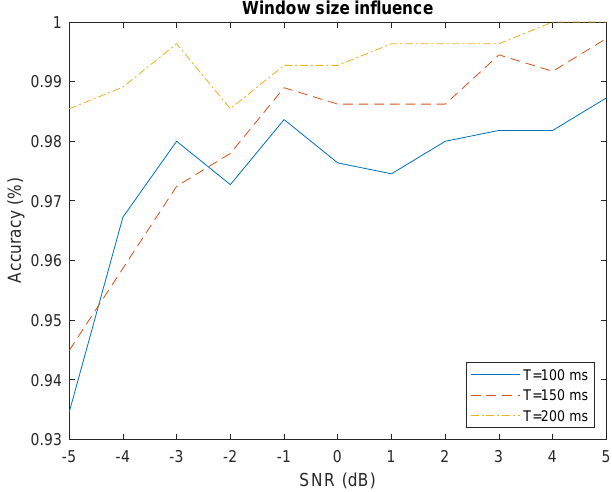
Figure 8. Influence of window size on